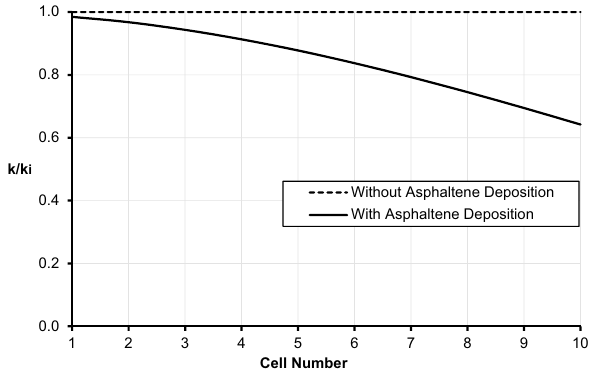
Fig. 6 Effect of asphaltene deposition on permeability alteration using k f / k m after 1 year of production